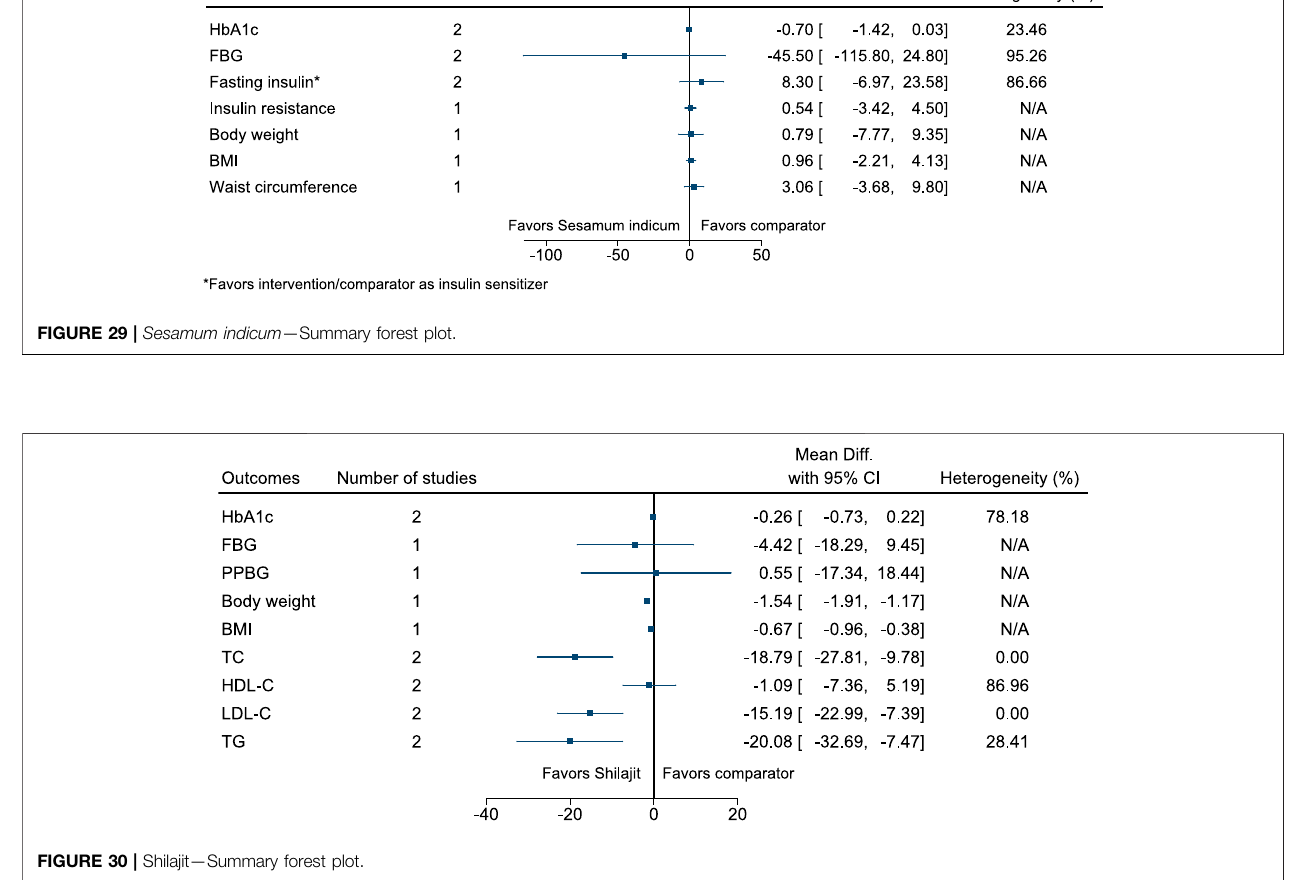
Frontiers in Pharmacology |